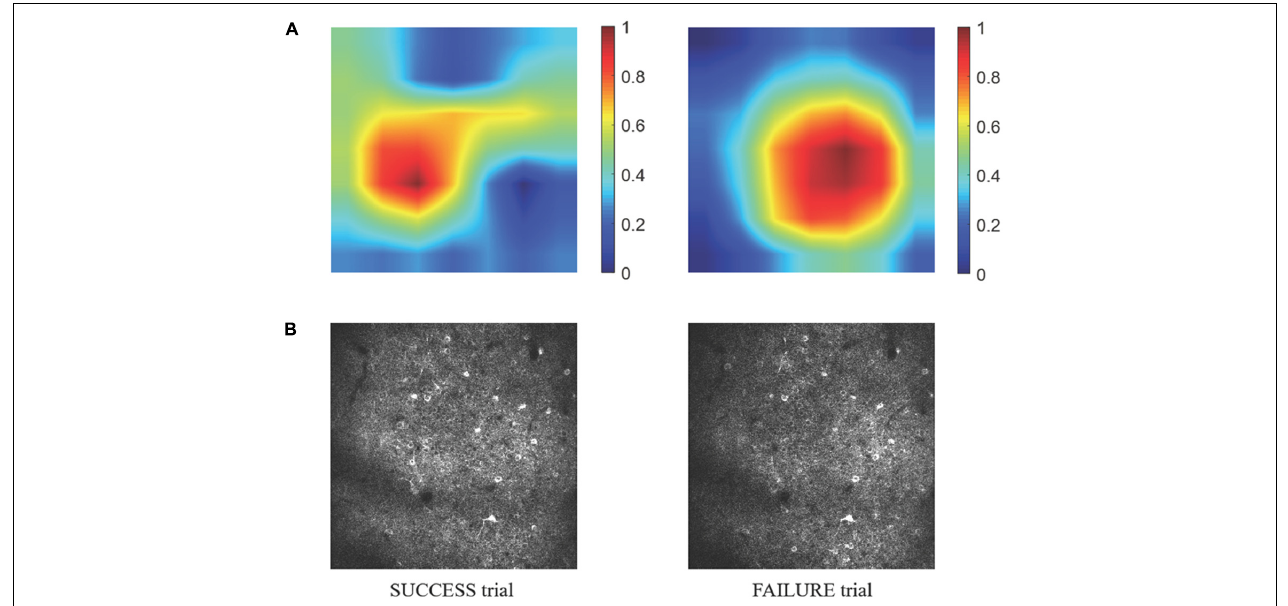
FIGURE 8 | (A) The specific discriminative regions used by the prediction model to predict SUCCESS (left) and FAILURE (right) are illustrated by the activation maps. The color indicates the relative value of M CAM . The higher the M CAM value, the more important the corresponding area is in prediction. The data are from mouse 9L. The corresponding raw average calcium images are shown in (B)